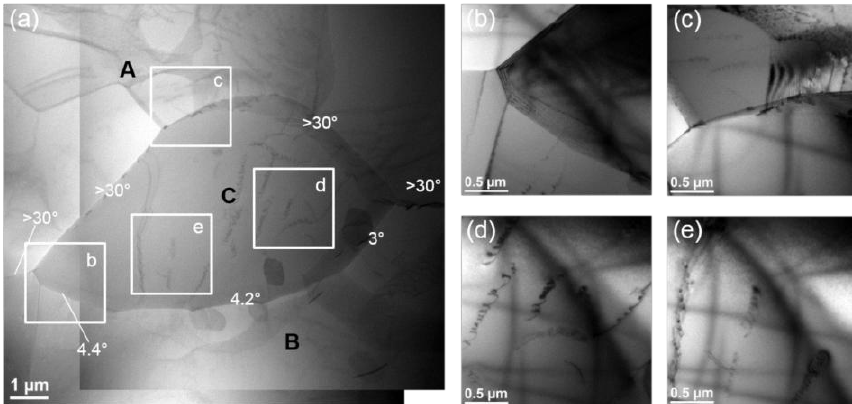
0.01 s −1 to a true strain of 0.8: ( a ) STEM image showing one dynamically recrystallized grain and its surroundings; and ( b – e ) bright-field TEM images illustrating the enlarged views of four locations in ( a